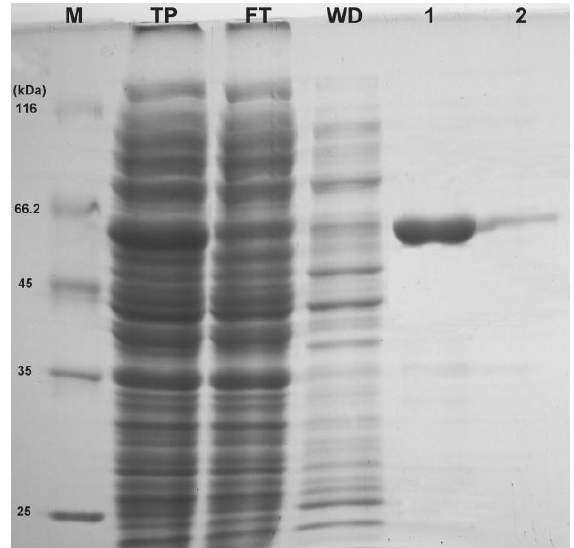
Figure 3. Purification of rEcPP5. M : protein marker; TP : total soluble cell lysate; FT : flow-through elution; WD : wash-down elution; 1 : 50 mM imidazole elution; 2 : 150 mM imidazole